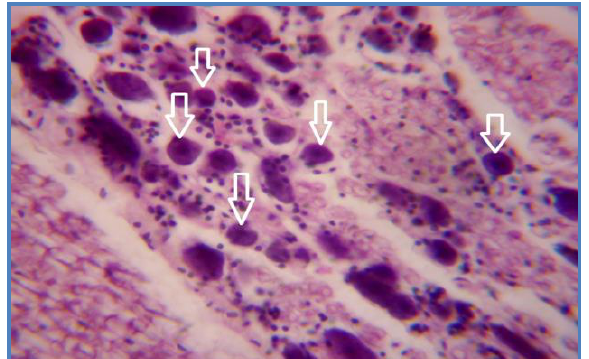
Figure, 6: Adult group sensory neurons, large size neuron (black arrow), small size neurons (white arrows). 100X. H and E.